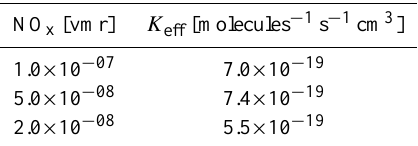
Table 1. Effective rate constants for O 3 destruction at high NO x concentration computed for typical marine boundary layer condi-